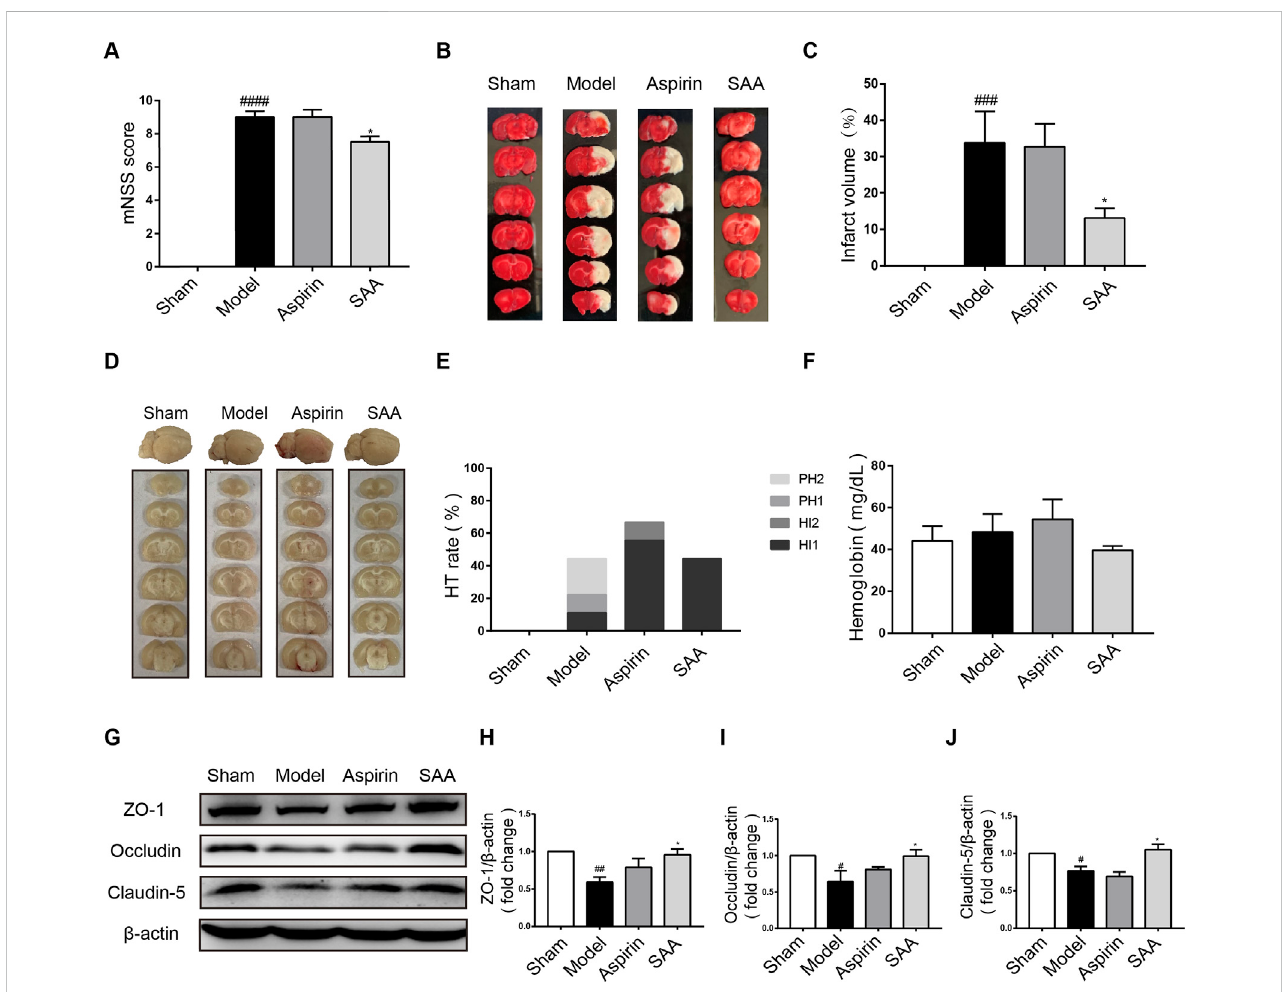
FIGURE 5 Preventive effects of SAA on rat ischemia injury. (A) mNSS at 24 h after ischemia with preventive administration of SAA. (B, C) The effects of SAA on cerebral infarction with 3d preventive administration. (D) The occurrence of hemorrhagic transformation in brain after SAA preventive administration. (E) Incidence of HT after SAA preventive administration. (F) The content of cerebral hemoglobin after SAA preventive administration. (G – J) Representative Western blot of Occludin, Claudin-5 and ZO-1 after SAA preventive administration 3d ( n = 4). n = 6, mean ± SEM, # p < 0.05, ## p < 0.01, ### p <